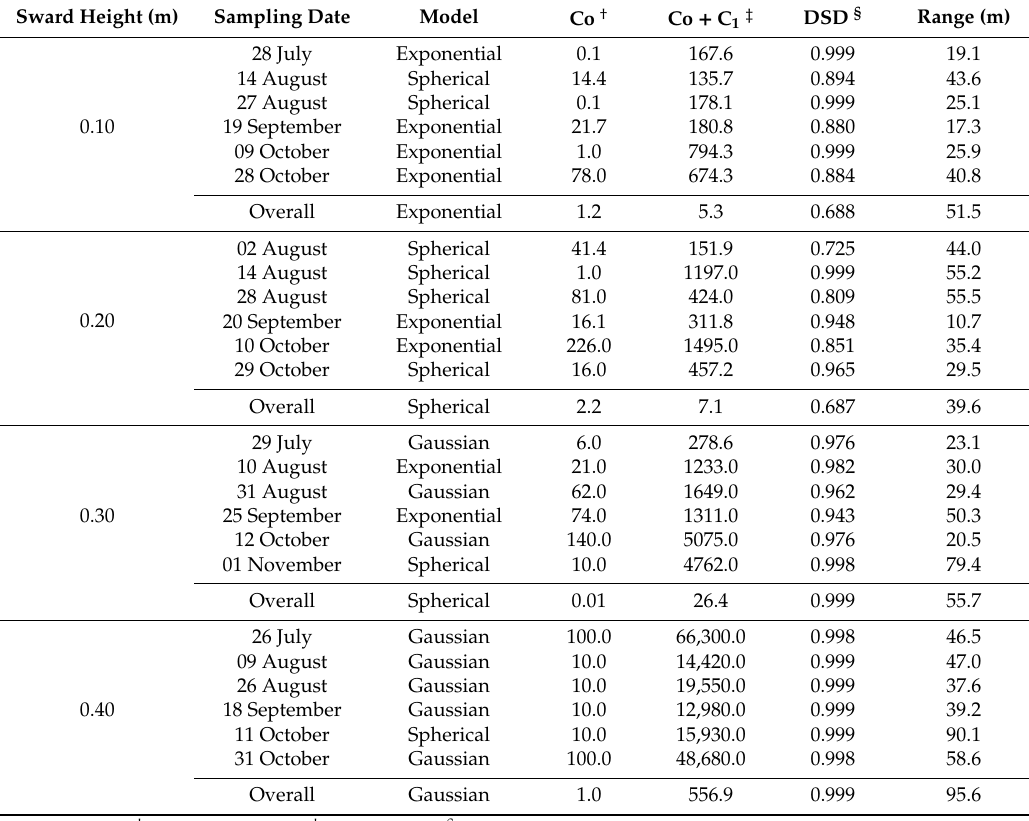
Table 3. Adjusted theoretical models of the areas of Thiessen polygons around dung patches in each sampling date in 2010 in paddocks managed at di ff erent grazing intensities (sward heights of 0.1, 0.2, 0.3 and 0.4 m) on mixed black oat ( Avena strigosa Schreb.) and Italian ryegrass ( Lolium multiflorum Lam.) pastures in the stocking period of an integrated soybean-beef cattle system in southern Brazil. Sward Height